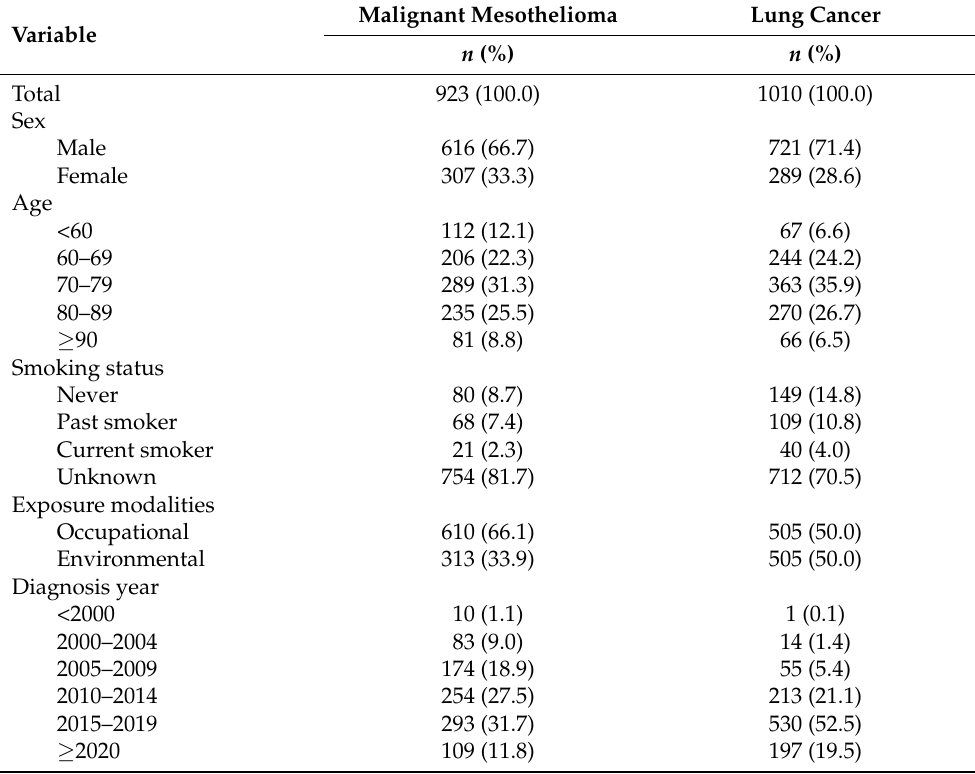
Table 1. Characteristics of study population with malignant mesothelioma and lung cancer.